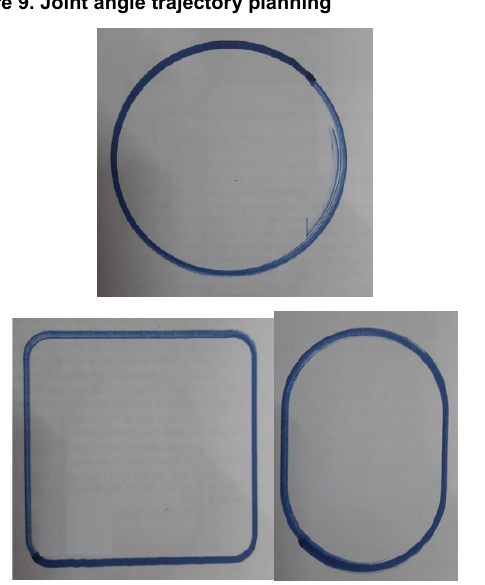
Figure 10. Robot movement